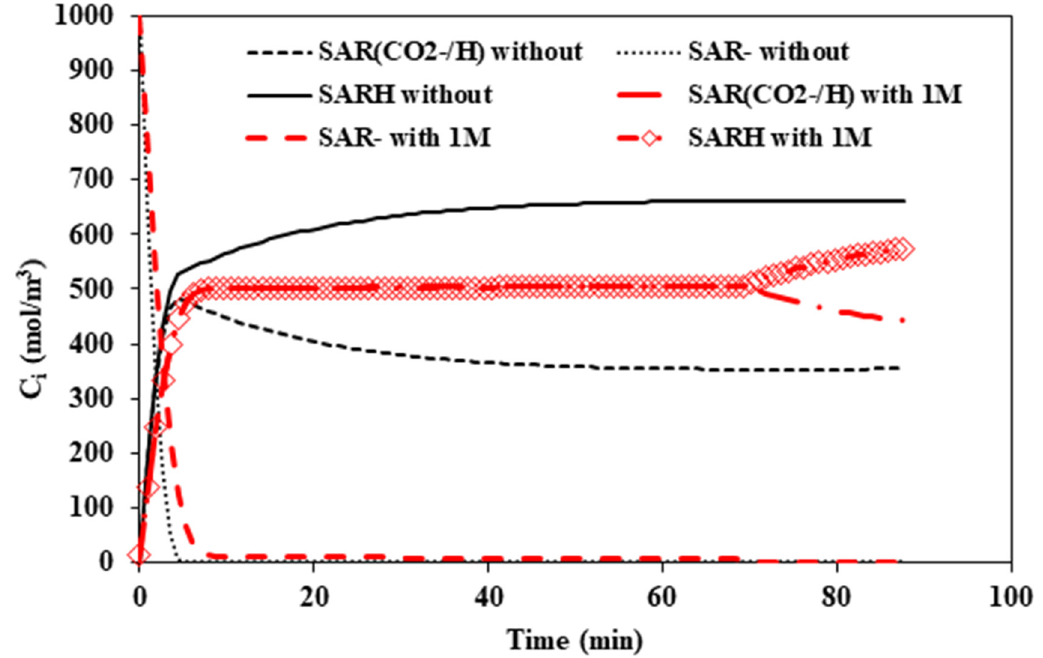
Energies 2021 , 14 , x FOR PEER REVIEW 9 of 15